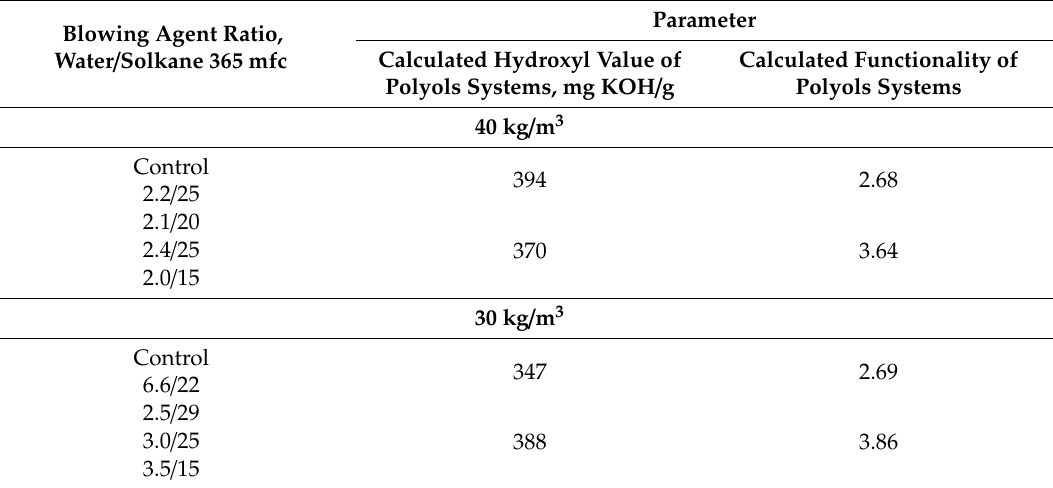
Table 4. Chemical characteristics of the polyol